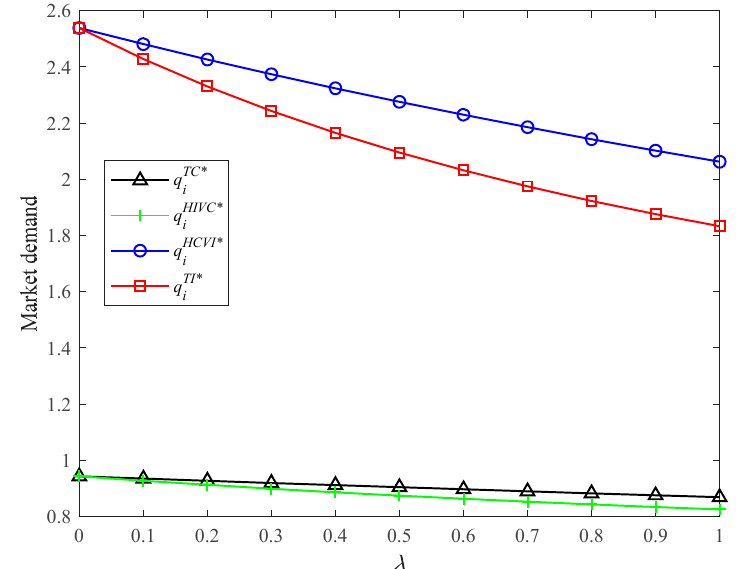
Figure 3. Market demands in four models with different 𝜆.